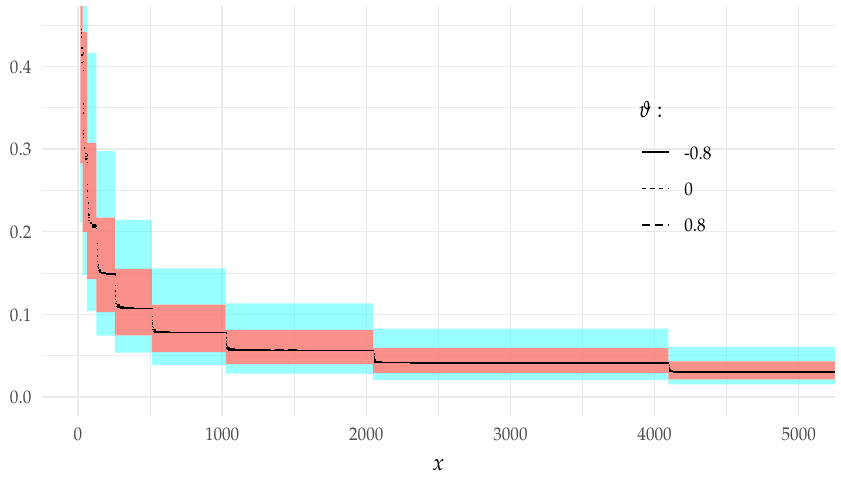
Figure 2. Simulated and asymptotic values for the truncated expectation of Example 4. Red area represents the region bounded by reflects the additional error using bounding coefficients L ξ